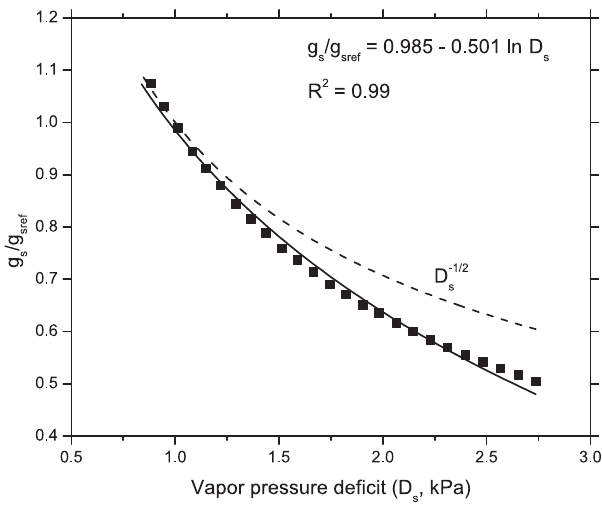
Figure 4. Relationship between g s and D s derived for SPA- WUE optimization. g sref is the stomatal conductance at D s = 1kPa. The solid line shows the best-fit regression equation using the relationship g s /g sref = y 0 + m ln D s from Katul et − 1 / 2 al. (2009). The dashed line shows D s . Calculations used ι = 750µmolCO 2 mol − 1 H 2